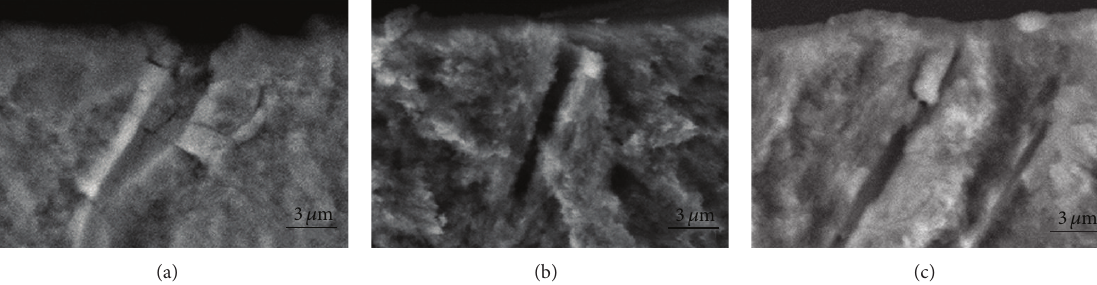
Figure 5: Cross-sectional scanning electron microscope (SEM) micrographs. (a) Control group (C), (b) laser only (L − ), and (c) the laser plus nanohydroxyapatite paste (L+). The original magnification was ×